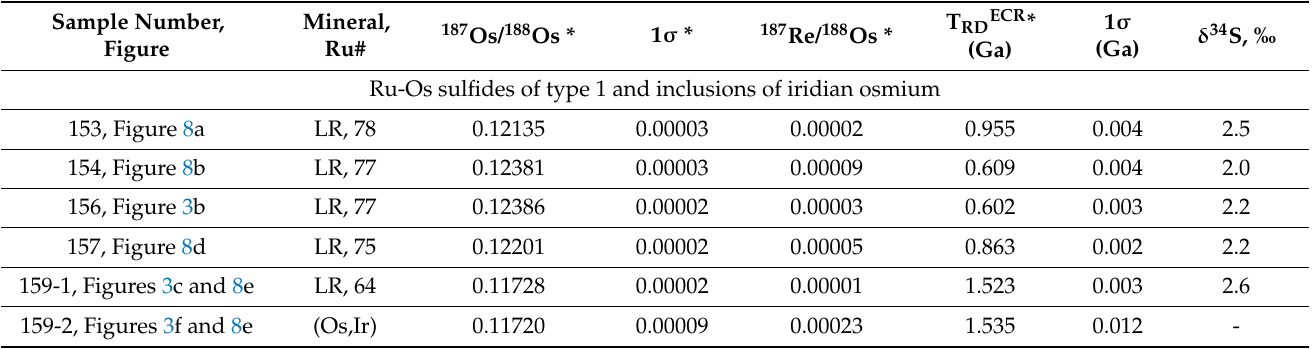
Table 4. Sulfur and osmium isotope data of Ru-Os sulfides and associated Os-rich alloys at Verkh-Neivinsk. Sample Number, Mineral, Figure Ru-Os sulfides of type 1 and inclusions of iridian